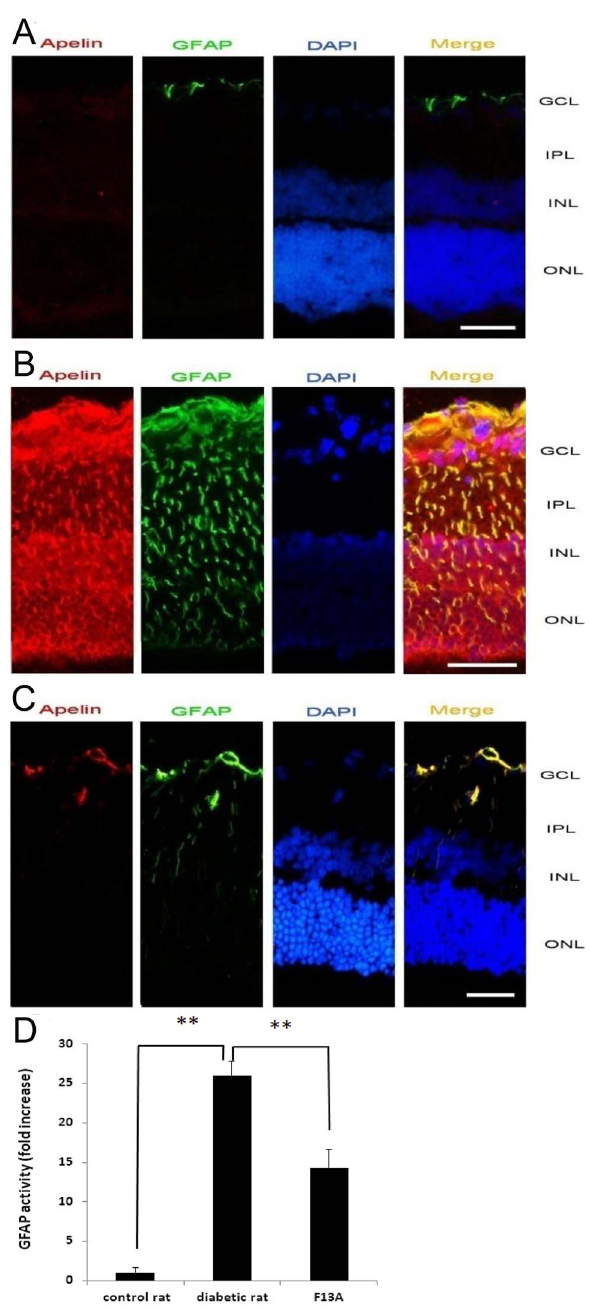
Figure 1. Indirect immunofluorescence evaluation of apelin and GFAP distribution in the retinas of normal rats (A), diabetic rats (B), and F13A-injected diabetic rats (C). Densito- metric quantification of GFAP activity is shown (D). Cryosections adjacent to those presented in Figure 1 were probed with antibodies against apelin and GFAP and were detected using fluorochrome- conjugated secondary antibodies. Nuclei were detected using DAPI. Merged images contain three color channels representing apelin (red), GFAP (green), and DAPI (blue). GCL, ganglion cell layer; INL, inner nuclear layer; IPL, inner plexiform layer; ONL, outer nuclear layer; F13A, F13A-injected group. ** indicates p , 0.01. Scale bars: 50 m m.